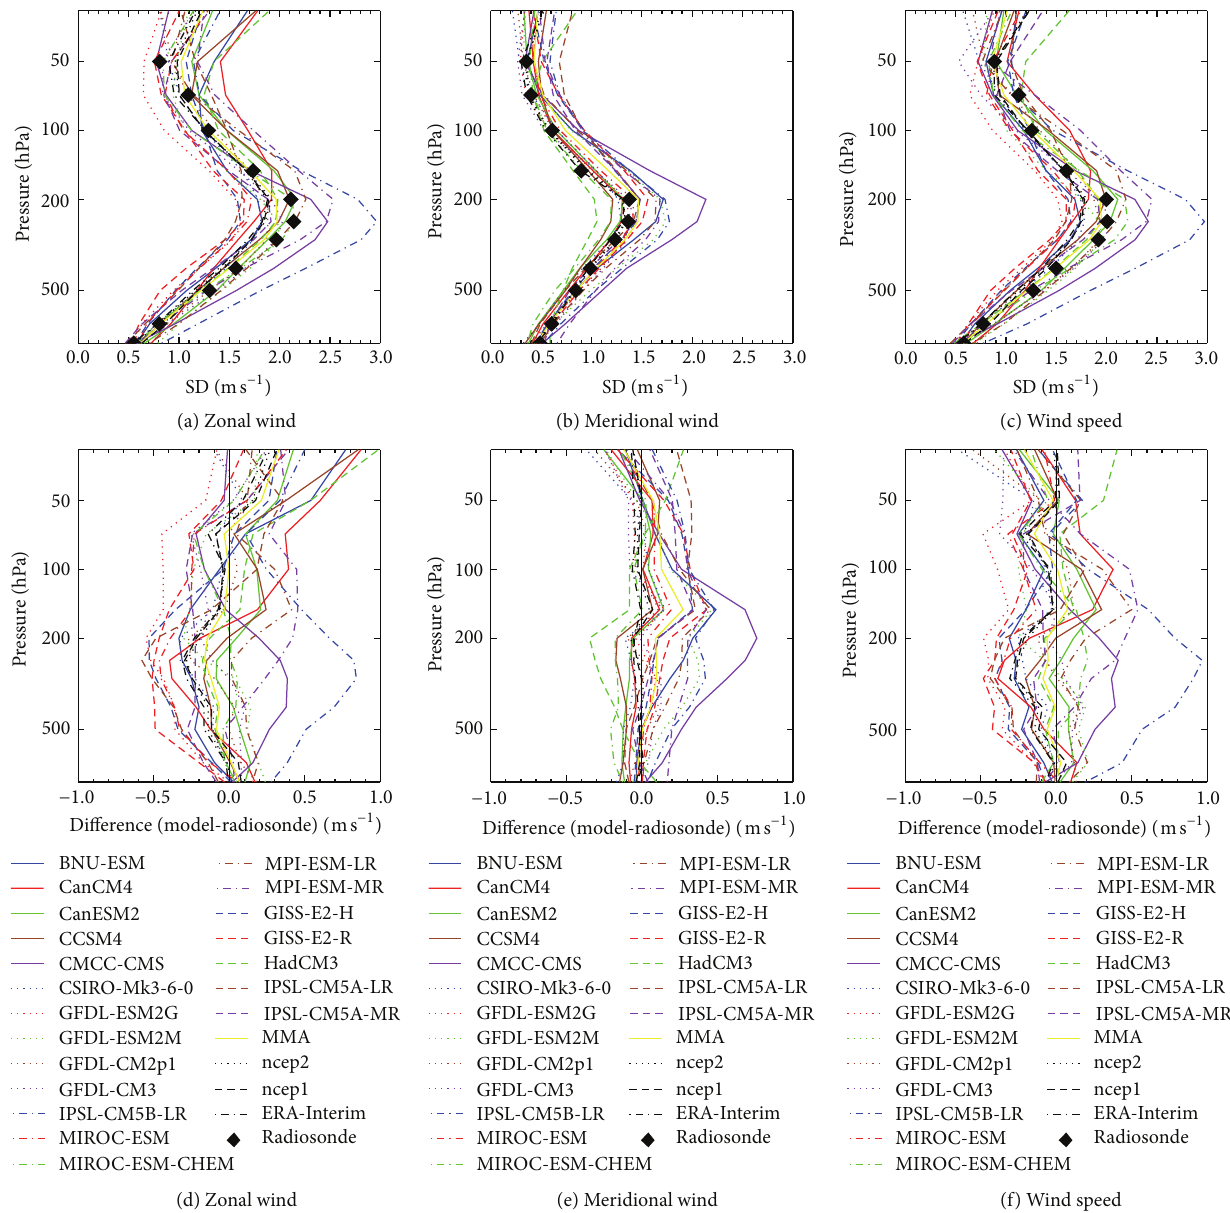
Figure 6: Similar to Figure 4 but for comparison of radiosonde, reanalysis, and CMIP5 model wind fields interannual variability (a, b, and c) and bias with respect to radiosonde (d, e, and f). Data is from 1979 to 2005.